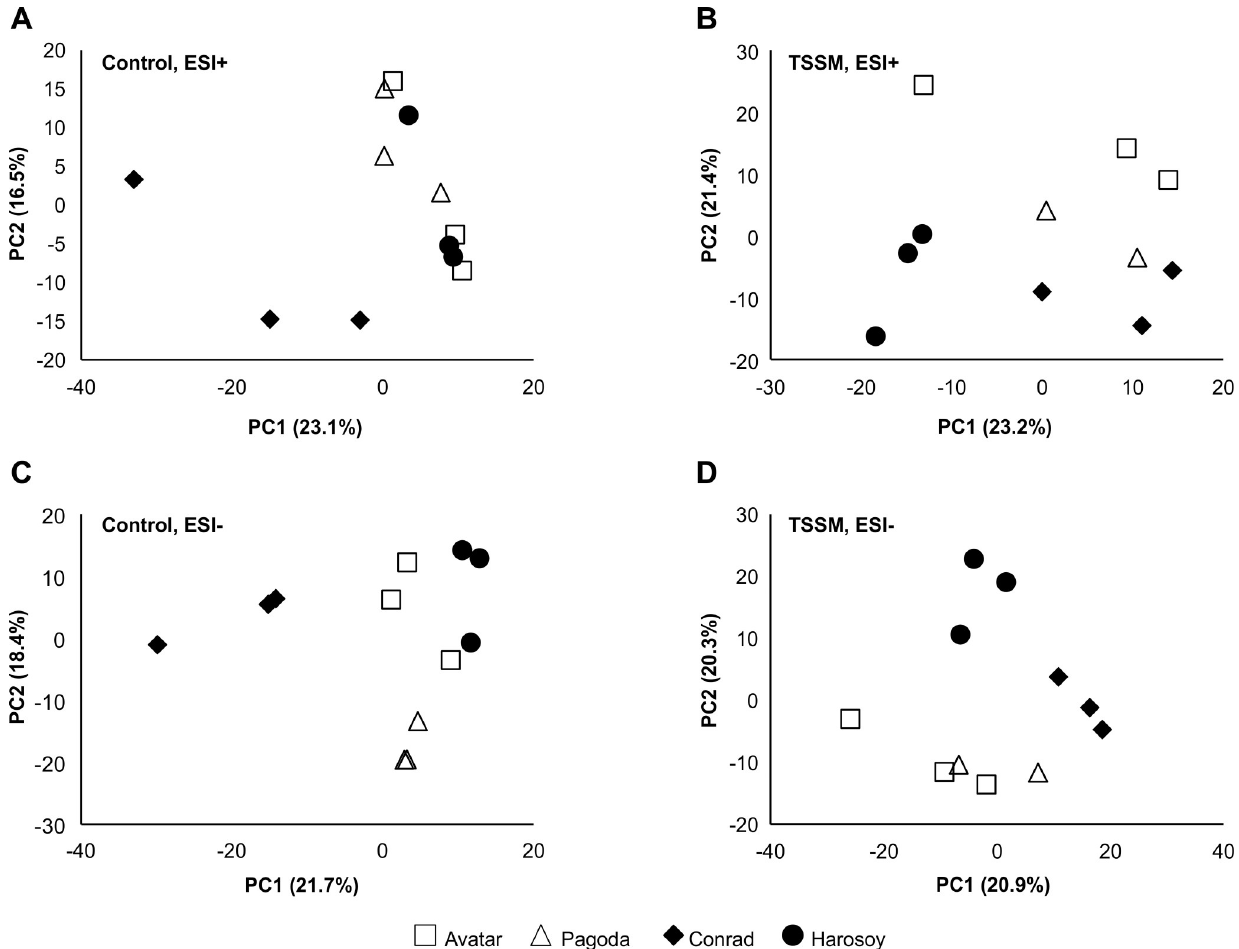
Fig 7. PCA plots derived from XCMS extracted features of resistant (white) and susceptible cultivars (black). (A) cultivars without mites, ESI + ; (B) cultivars with mites, ESI + ; (C) cultivars without mites, ESI - and (D) cultivars with mites, ESI - . Each symbol represents one of 3 biological replicates.